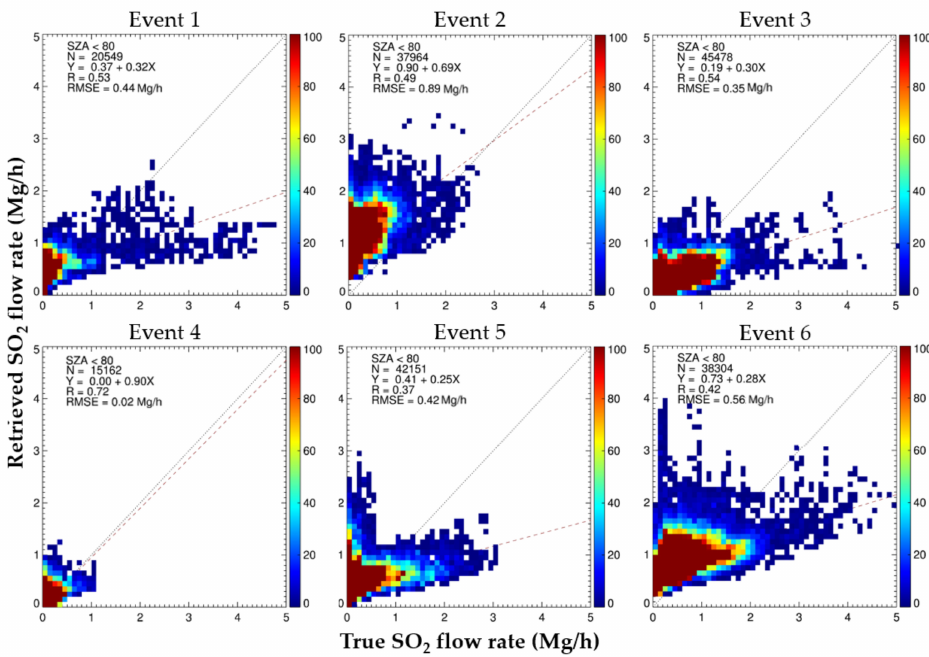
Figure 18. Correlation between true and calculated SO 2 flow rates under conditions of errors in both wind data and SO 2 VCDs for each event in Table